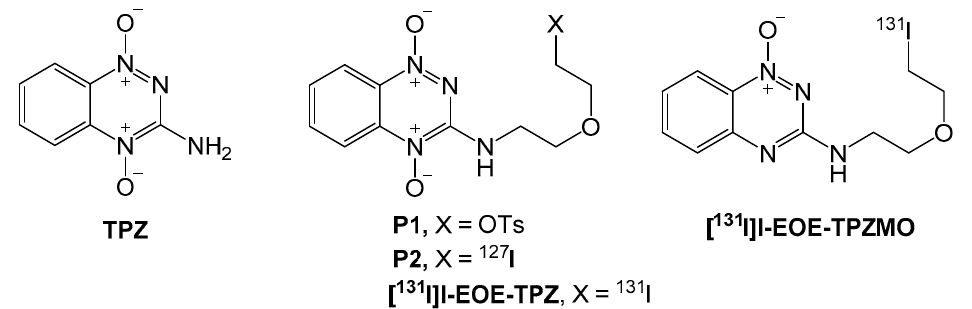
Figure 1. Structures of TPZ (tirapazamine), P1 (Tos-EOE-TPZ; X = tosyl), P2 (I-EOE-TPZ; X = I = 127 I), and [ 131 I]I-EOE-TPZMO.